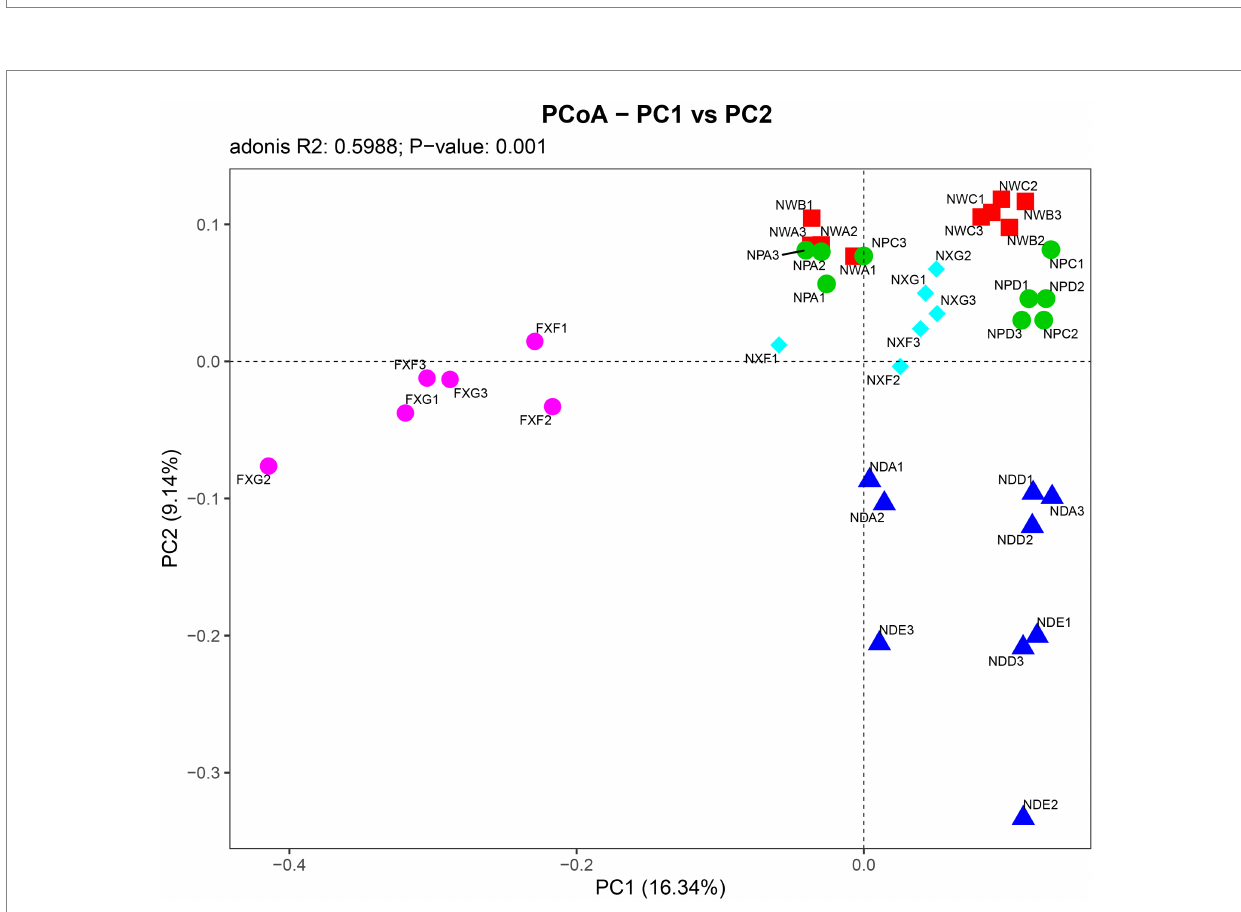
FIGURE 3 Associations between individual samples were explained by PCoA analysis. Symbols of the same color show sample from a similar habitat type and the distance between symbols display their dissimilarity. The detailed meaning of each sample was shown in Table 1, 1~3 represented three biological